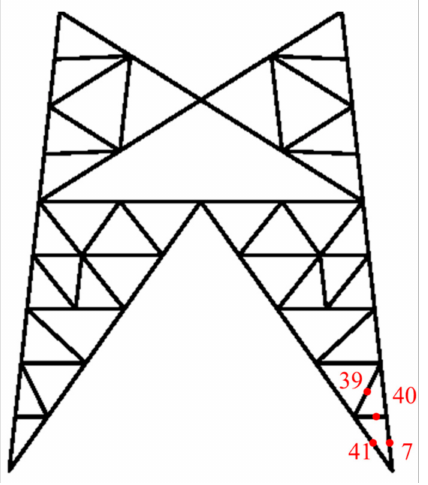
Figure 7. Strain observation point